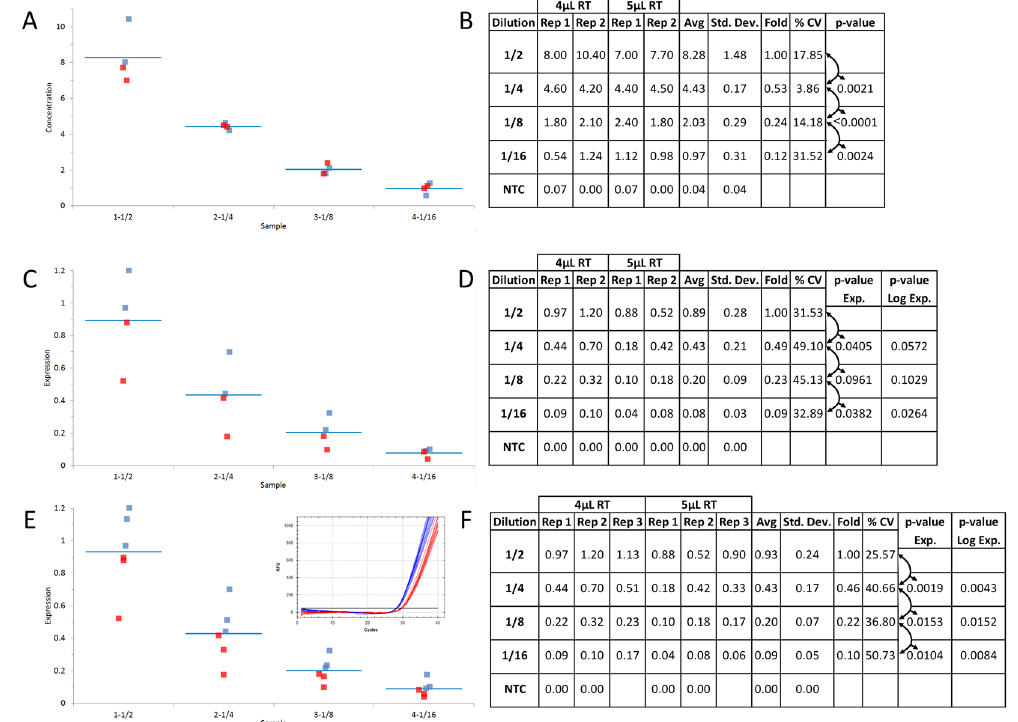
Figure 4. Reference gene normalization can improve qPCR precision depending on contaminant levels and number of replicate samples. The reproducibility of the data between the combined reactions at each 1/2 dilution of DNA (Fig. 2) was compared between ddPCR and qPCR technologies with normalization to the same synthetic target amplified from a consistent amount of DNA at each level of RT contaminant. Box plot ( A ) from four combined ddPCR reactions supplemented with 4 uL and 5 uL of RT mix and tabulated absolute concentration data from the combined ddPCR reactions ( B ). Box plot ( C ) from qPCR data generated from the same four reactions as described in A with normalization to the same target at a consistent DNA concentration between the RT contaminated samples (E inset) and tabulated normalized relative fold difference ( ΔΔ Cq) ( D ). Box plot ( E ) from qPCR data generated from all six reactions as described in Fig. 2 with normalization to the same target at a consistent DNA concentration between the RT contaminated samples (E inset) and tabulated normalized relative fold difference ( ΔΔ Cq) ( F ). Blue and Red traces and graphed data points from qPCR and ddPCR reactions supplemented with 4 uL and 5 uL of RT mix respectively. NTC: No Template Control; Dilution: Dilution factor of DNA samples; Rep: Replicate number; Avg: Average of the replicates; Std. Dev.: Standard Deviation between the replicates; % CV: % Coefficient of Variance (Std. Dev./Avg * 100); p-value: based on a Student t-test of the Avg between each